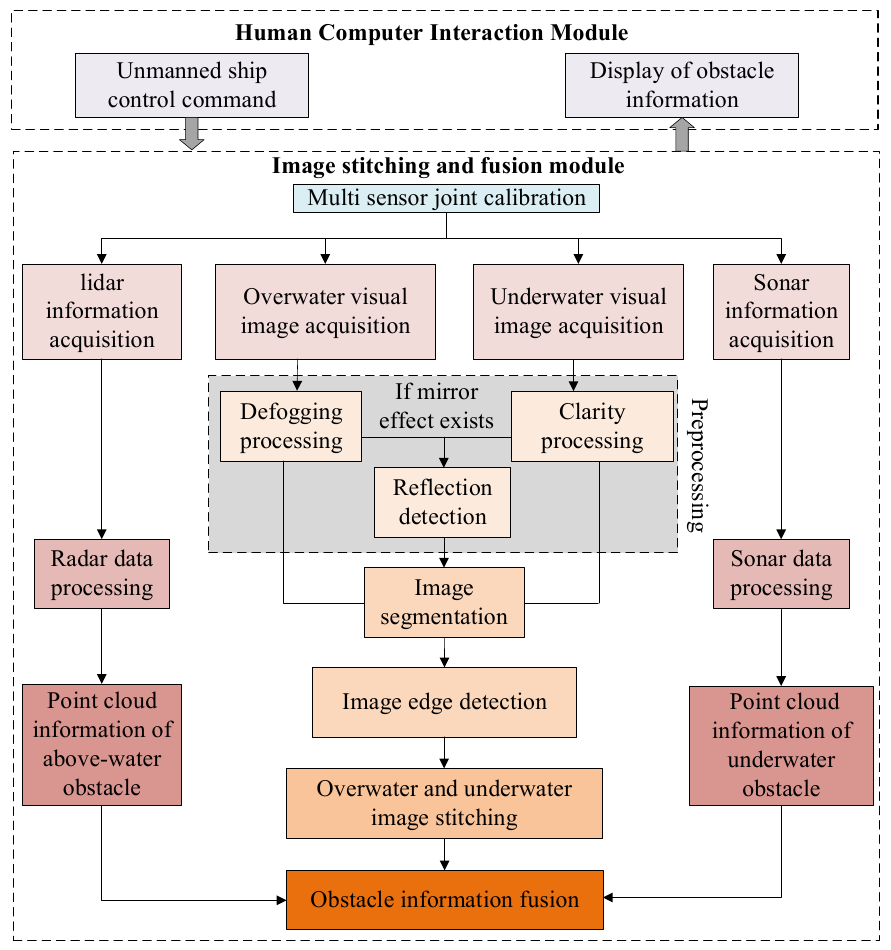
Figure 2. T he overall software framework of the visual image fusion system. Figure 2. The overall software framework of the visual image fusion